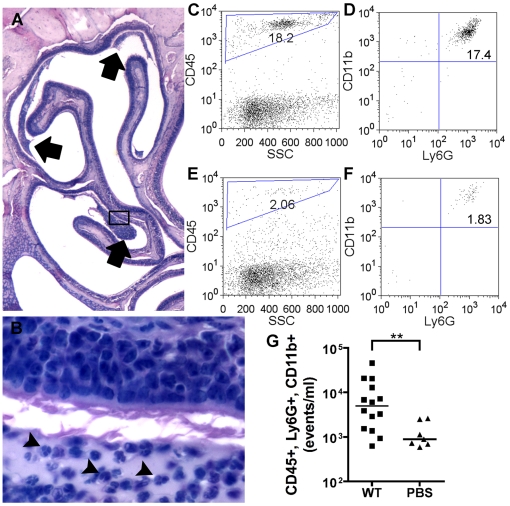

K. pneumoniae colonization elicits an acute inflammatory infiltrate.Mice colonized with wild-type K. pneumoniae KPPR1 were sacrificed at day 1 post-inoculation. Inflammatory infiltrates are seen adjacent to the turbinates of the nasopharynx (A, 20×, arrows) containing neutrophils (B, 600×, arrowheads). To enumerate the neutrophil influx, mice were sacrificed at day 3 post-inoculation for nasopharyngeal lavage, and 100 µL of lavage fluid was analyzed by flow cytometry. Neutrophils (CD45+, Ly6G+ and CD11b+) from a representative KPPR1 (C, D) or PBS mock-colonized (E, F) mouse lavage sample are shown. Compiled neutrophil counts are shown as a scatter plot; the bars represent median numbers of CD45+, Ly6G+, CD11b+ events/ml for each animal (G). p<0.01 by Mann-Whitney test.